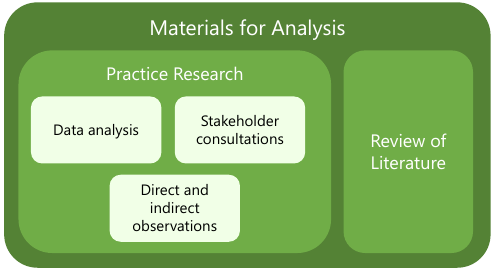
Figure 3. Materials forming the basis of